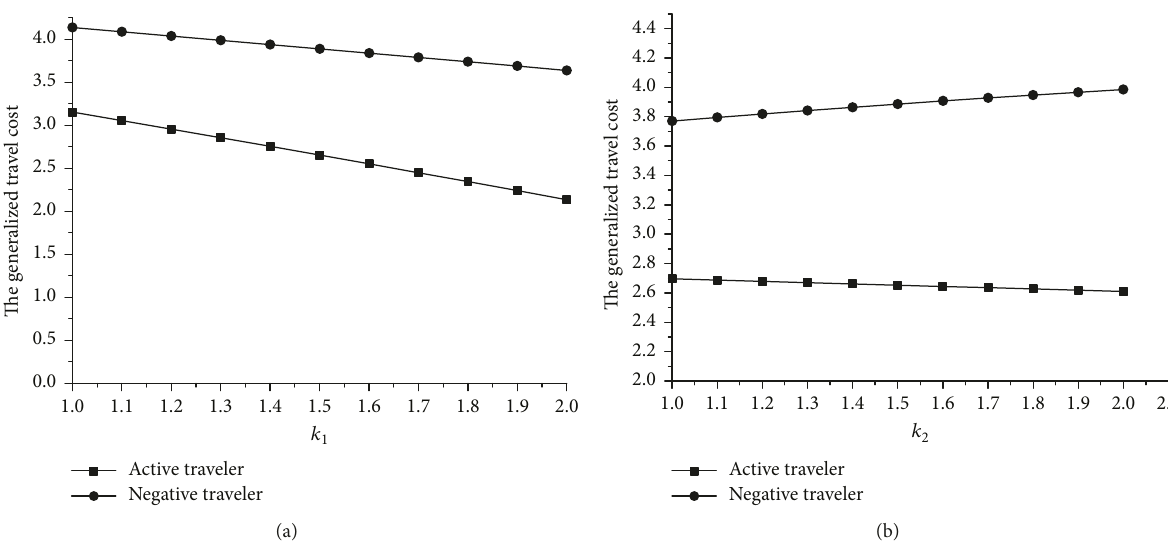
Figure 6: Changes of the generalized travel cost with respect to 𝑘 1 and 𝑘 2